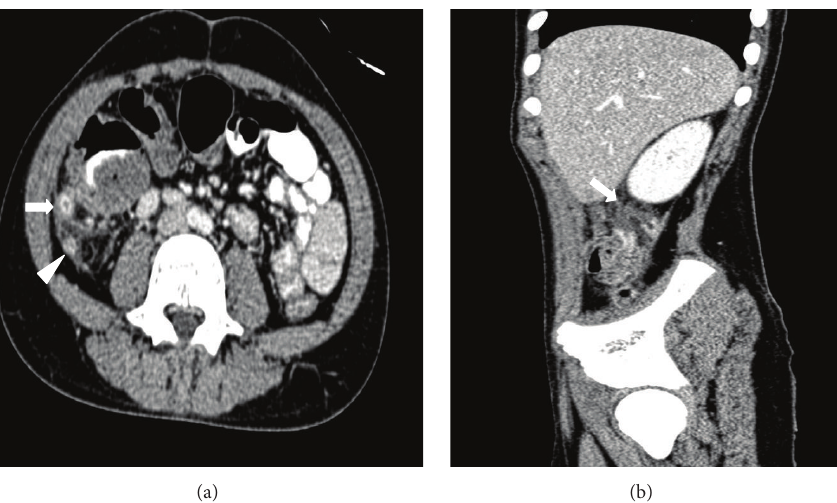
Figure 1: Contrast enhanced CT showing long, inflamed, and retrocaecal appendix with a distal kink. (a) Axial image showing inflamed (enhancing) appendix (proximal part-arrow and tip-arrow head). (b) Sagittal image showing the nonenhancing mid portion of the appendicular wall with kink (arrow) and no periappendicular collection.